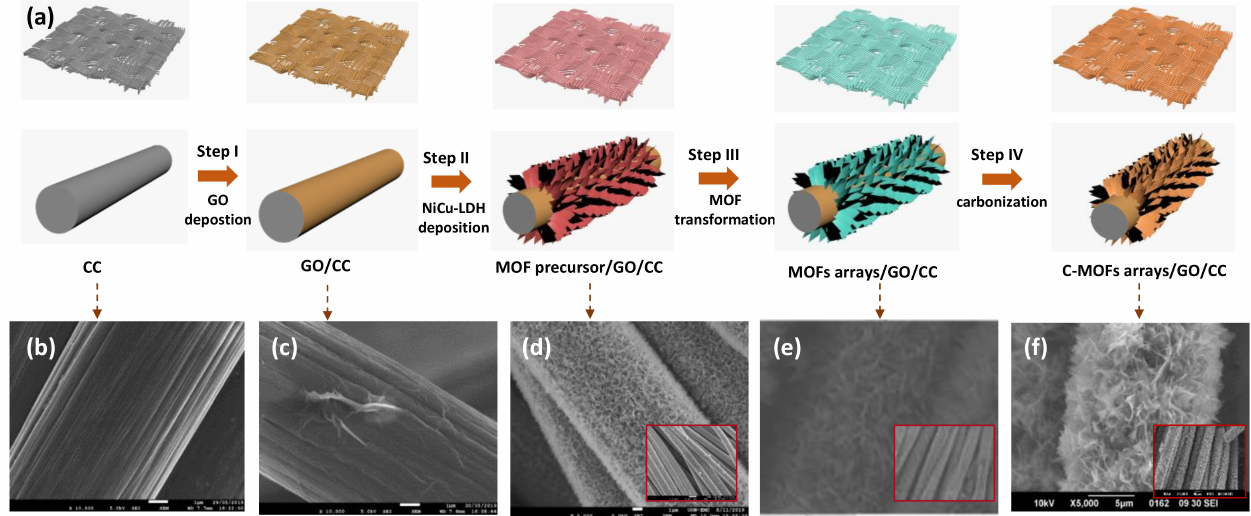
Figure 1. ( a ) The schematic illustration of synthesizing C–NiCu–MOFs; ( b , c ) SEM images of CC with pre-treatment and GO/CC; ( d – f ) SEM images of NiCu–LDH/GO/CC, NiCu–BDC/GO/CC, and C–NiCu–BDC/GO/CC.